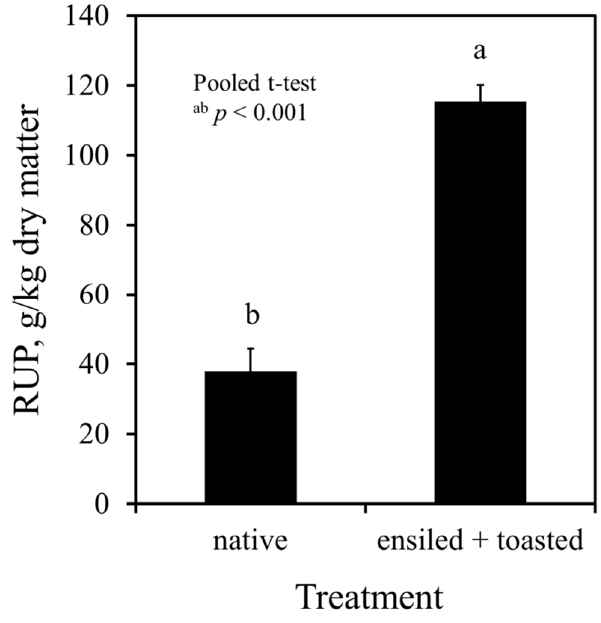
Figure 1. In vitro estimation of rumen-undegraded protein (RUP) in native and ensiled + toasted field pea grains using Streptomyces griseus protease (3.63 and 3.55 mL of 0.58 U / mL protease solution, respectively, and 24 h incubation time); native peas had 779 g DM / kg, 186 g CP / kg DM, and 179 g TP / kg DM; ensiled + toasted peas had 970 g DM / kg, 186 g CP / kg DM, and 175 g TP / kg DM; CP = crude protein, DM = dry matter, TP = true protein. Table 4. Crude protein composition of the field pea treatments.